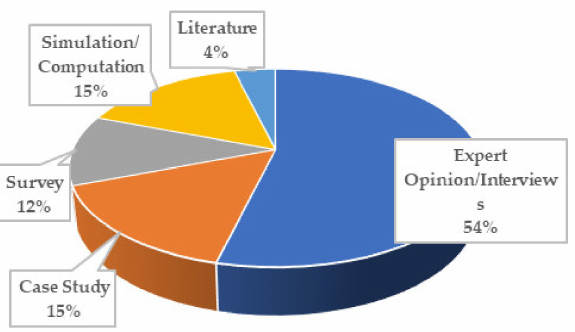
Figure 3. Distribution of data sources used in the articles listed in Table 1, selected via the search criteria related to Supply Chain Risk Management in the Apparel Industry